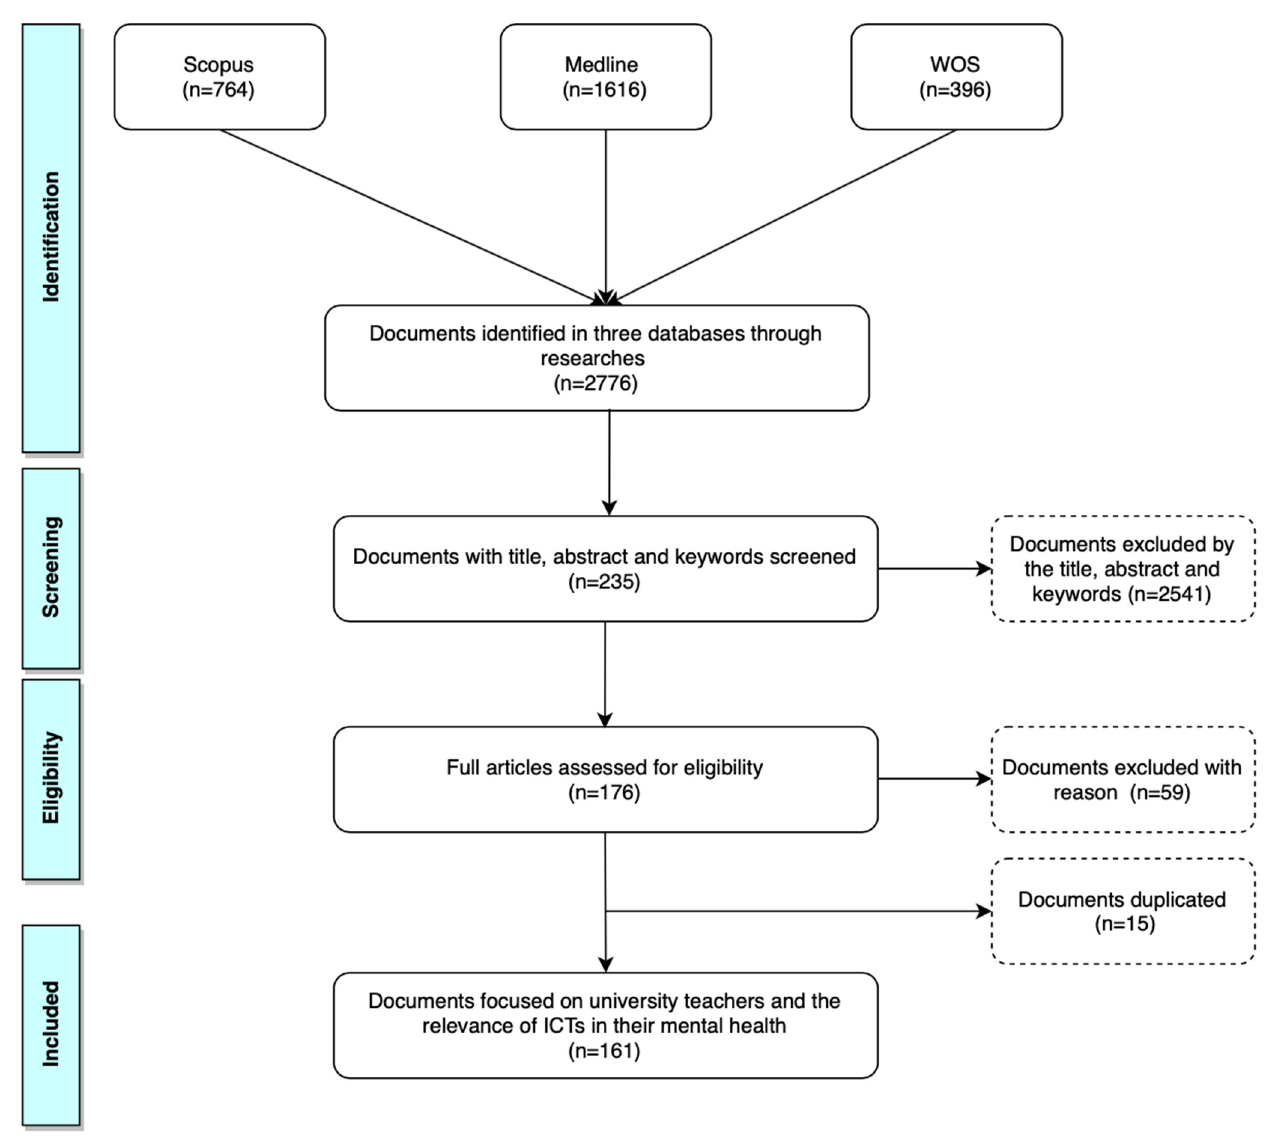
Figure 1. Flow diagram followed for collecting data using the stages of identification, screening, eligibility, and inclusion.